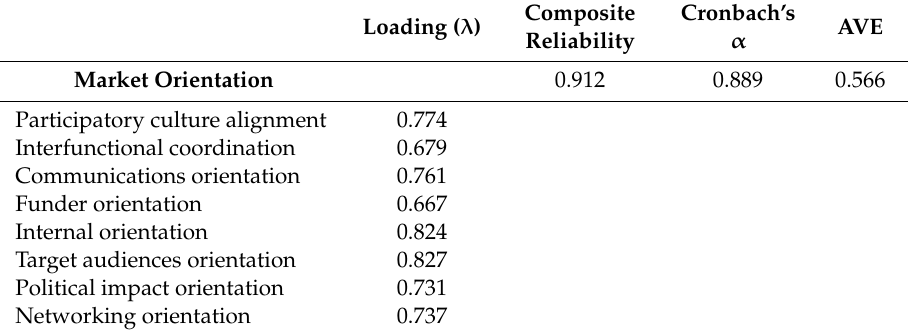
Table 7. Reliability and validity of the final